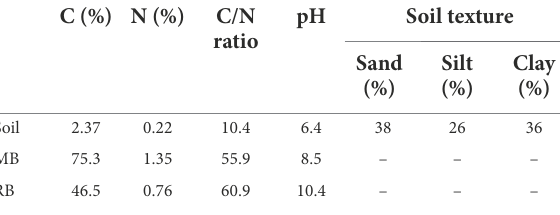
TABLE 1 Physicochemical properties of soil samples and